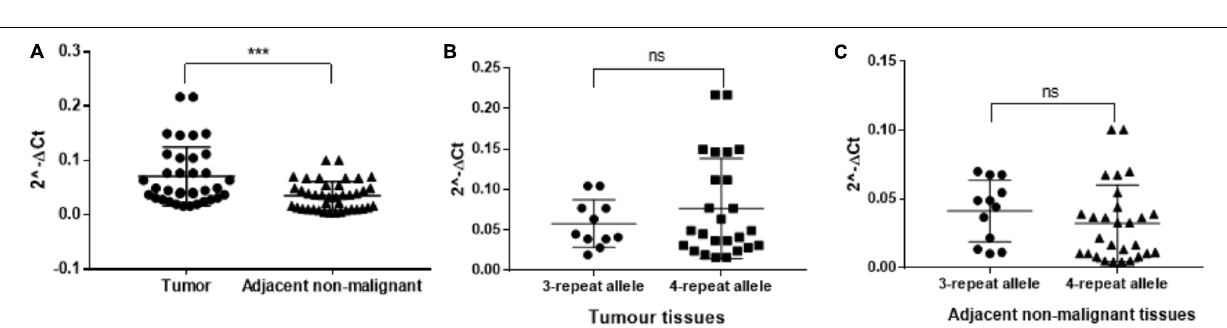
FIGURE 2 | Survival data analysis. (A) Total mortality data [Log-Rank (Mantel-Cox) P -value = 0.16], (B) prostate cancer mortality data [Log-Rank (Mantel-Cox) P -value = 0.43] where TTTTG- TRIB1 genotypes (3/3, 3/4, 4/4) are represented as a function of percentage survival over 125 months. HR and P -values were calculated using Cox-Regression analysis and adjusted for age, Gleason score and PSA values. HR, hazard ratio; CI, confidence interval.